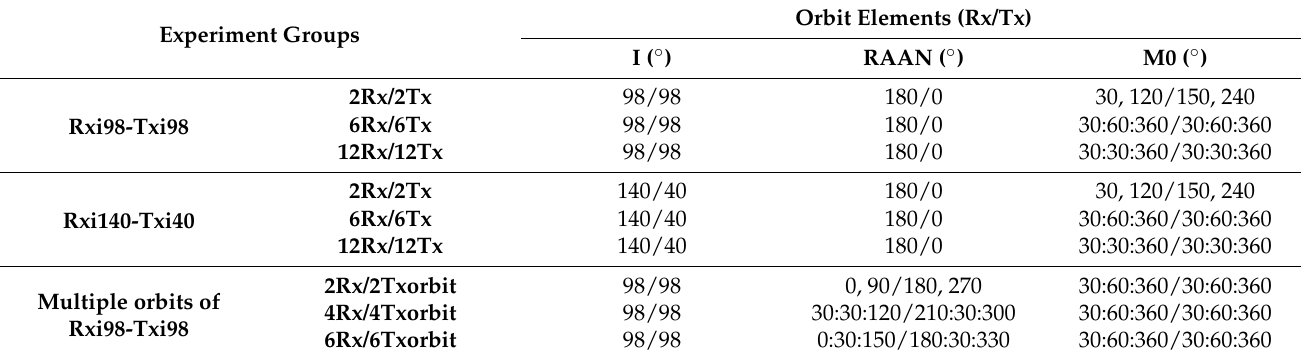
Table 3. The main orbital parameters of the transmitting and receiving satellites for multi-Rx and multi-Tx constellations. The chosen set of values for some elements is denoted in the format of StartValue:Step:EndValue; simulations were performed using an ensemble of configurations stepping through all value settings for these elements. Experiment